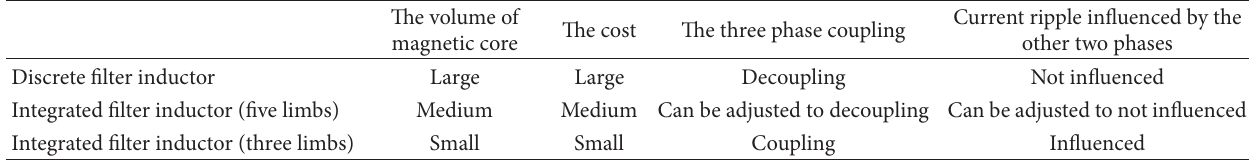
Table 1: The comparison of the discrete filter inductors and integrated filter inductors.